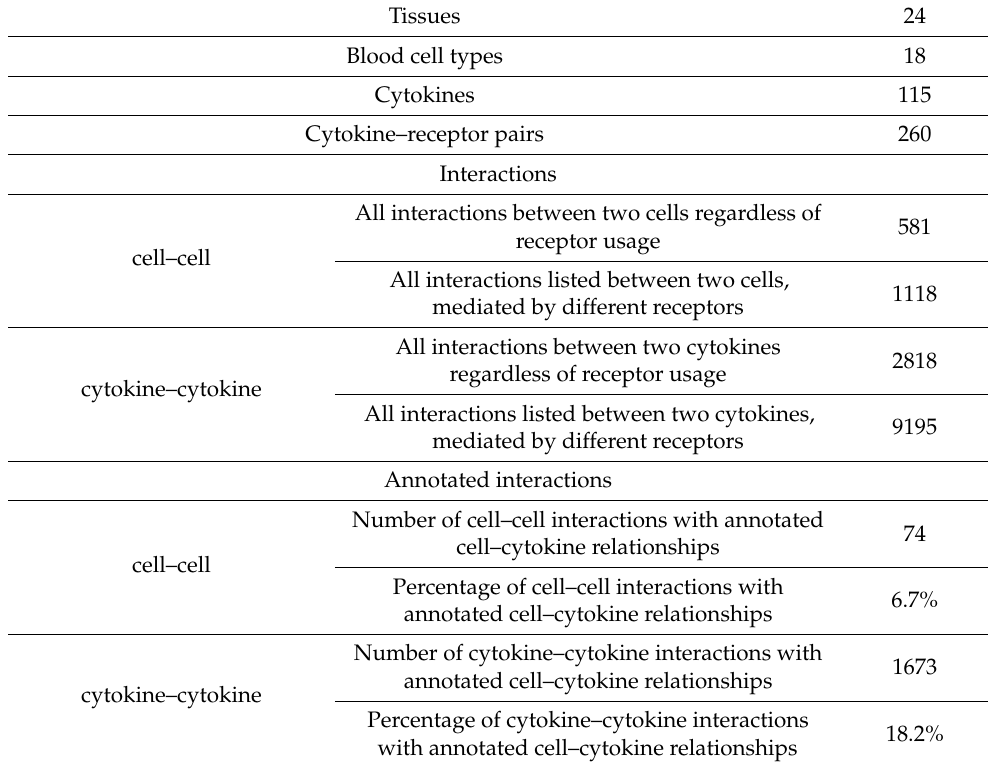
Table 2. Interaction data and annotations in CytokineLink. Annotated interactions refer to that at least one part of the underlying cell → cytokine interactions being listed in the literature in the ImmunoGlobe and immuneXpresso